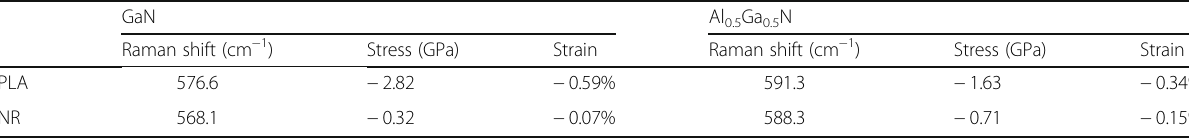
Table 2 The E 2 (high) phonon frequencies (cm − 1 ) observed at 300 K and the calculated stress and